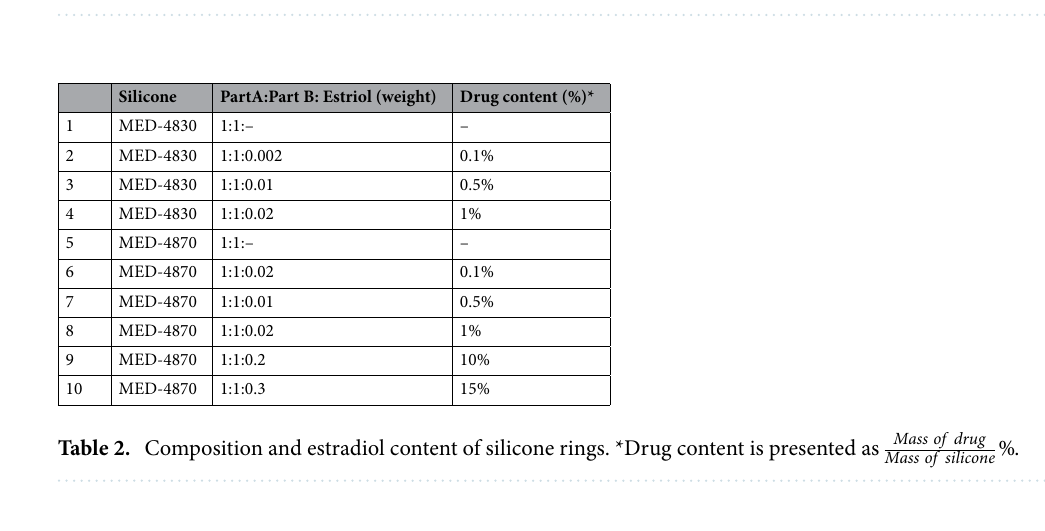
Figure 7. Injection mold and ring design sketch: ( a ) injection mold model, ( b ) ring model and ( c ) mold and ring solid model.